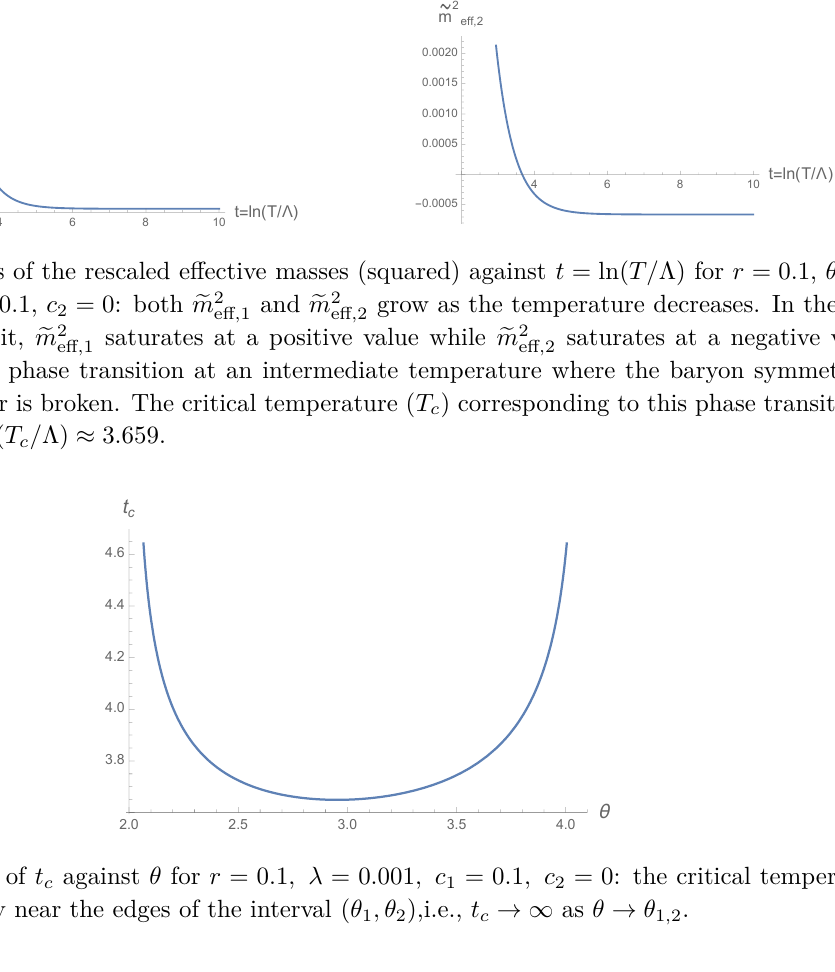
) ,i.e., t as θ → θ 1 , θ 2 c → ∞ 1 , 2